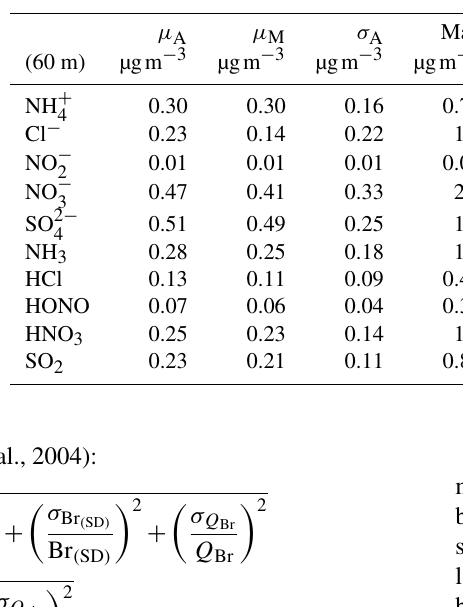
Table 1. Mean ( µ A ), median ( µ M ), arithmetic standard deviation ( σ A ), maximum, minimum and number of measurements for water-soluble aerosol and inorganic trace gas concentration measurements taken at 60m on the 80m tower, with associated limit of detection (LOD) values for each species based on 30min